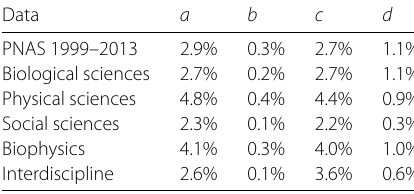
Table 2 Specific statistical indexes of the analyzed